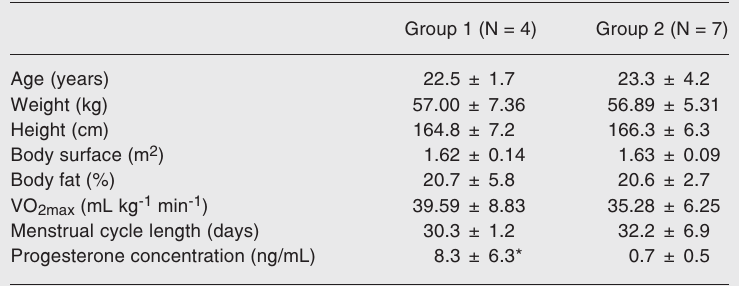
Table 1. Baseline characteristics of the two groups of